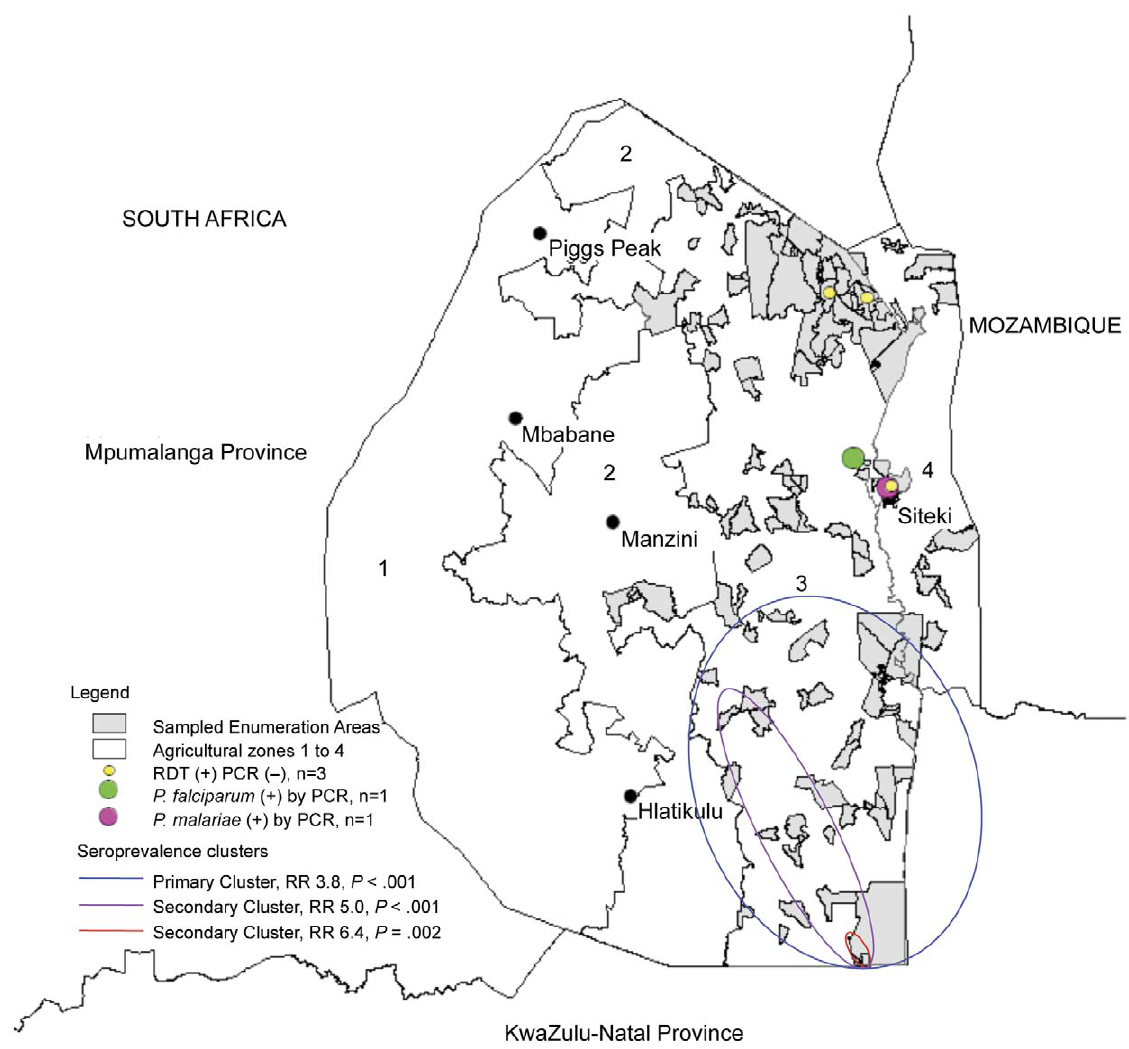
Figure 2. Map of Swaziland with RDT or PCR-positive participants and potential hot spots identified in serologic cluster analysis.